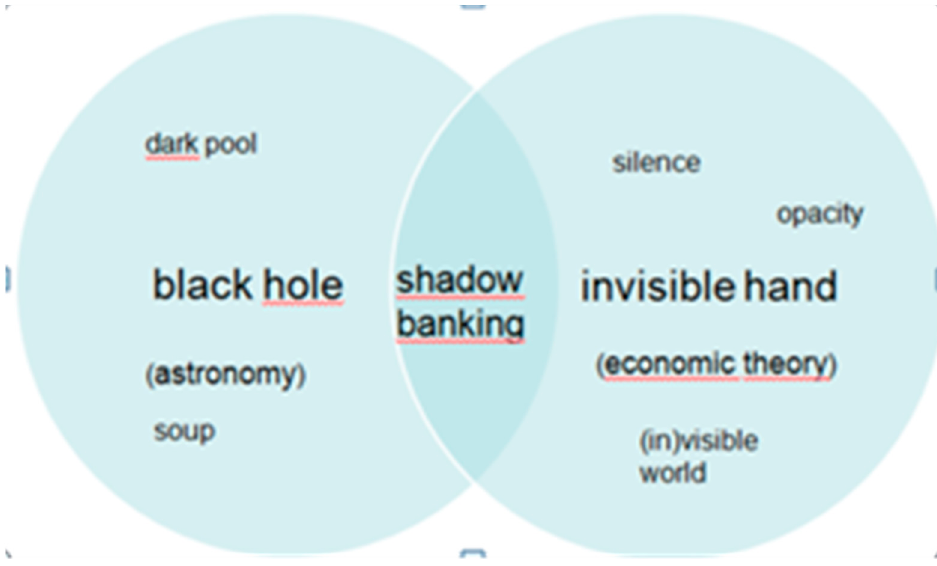
Figure 2. Shadow banking as the result of a transfer from the domain of astronomy to economy.